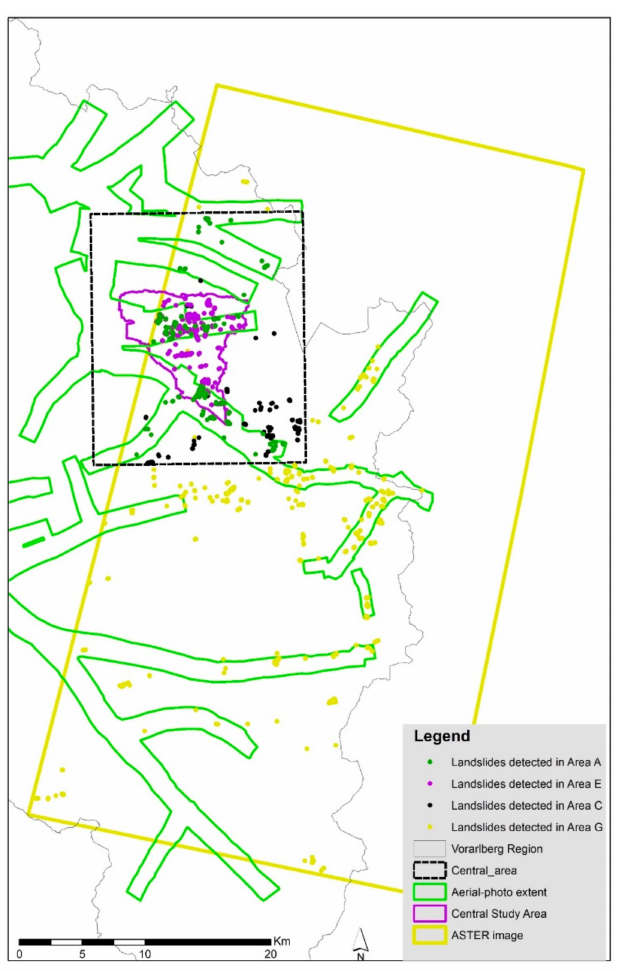
Figure 10. Regional landslide detection map applied to the Region of